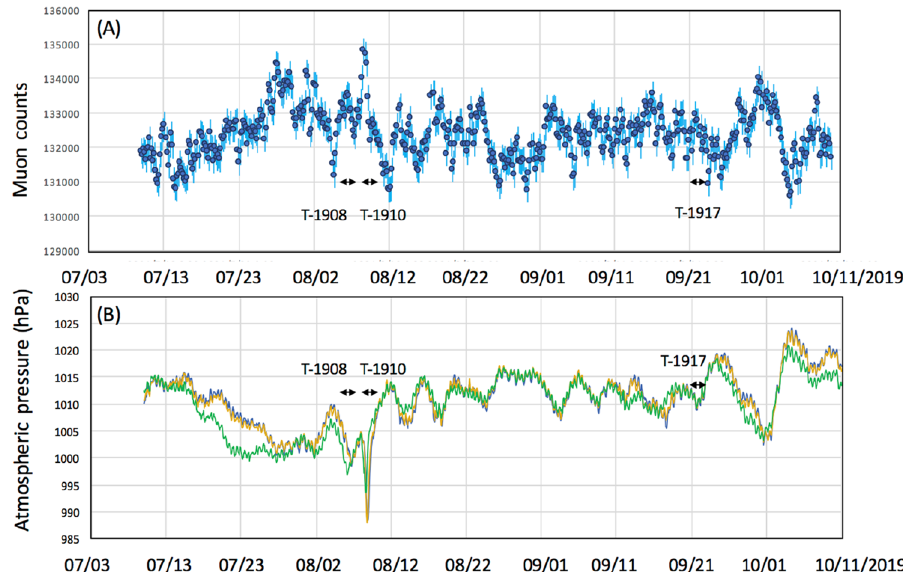
Figure 7. Observed time-dependent variations of the muon count rate in the 2019 typhoon season ( A ). The atmospheric pressure values observed at three BP monitoring stations of Kagoshima (blue), Yakushima (Orange) and Naze (Green) 48 are shown ( B ). The vertical bars associated with the data points indicate 1σ error bars. Arrows indicate the period that T1908, T1910, and T-1917 approached.